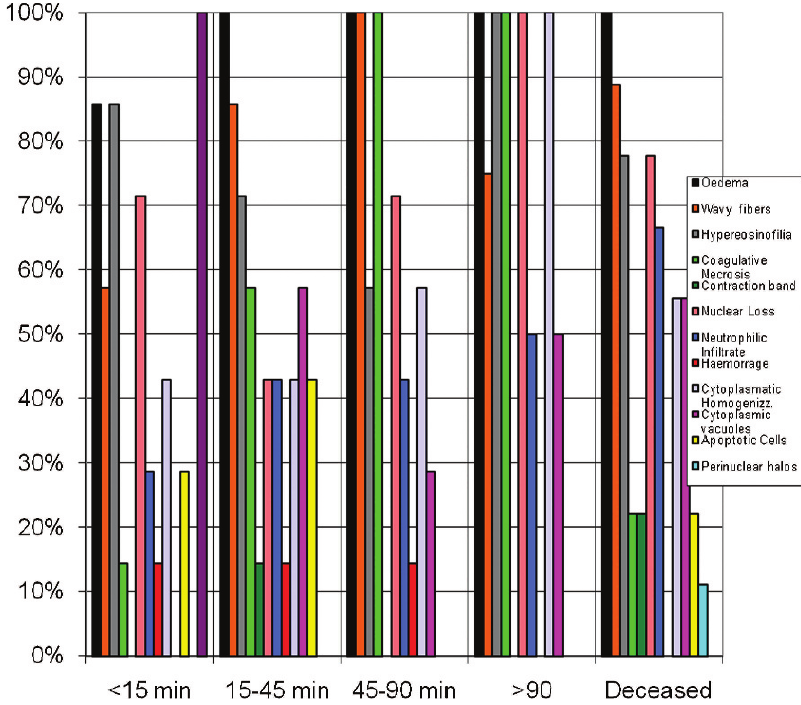
Figure 6 - Changes in cardiomyocytes with respect to recovery